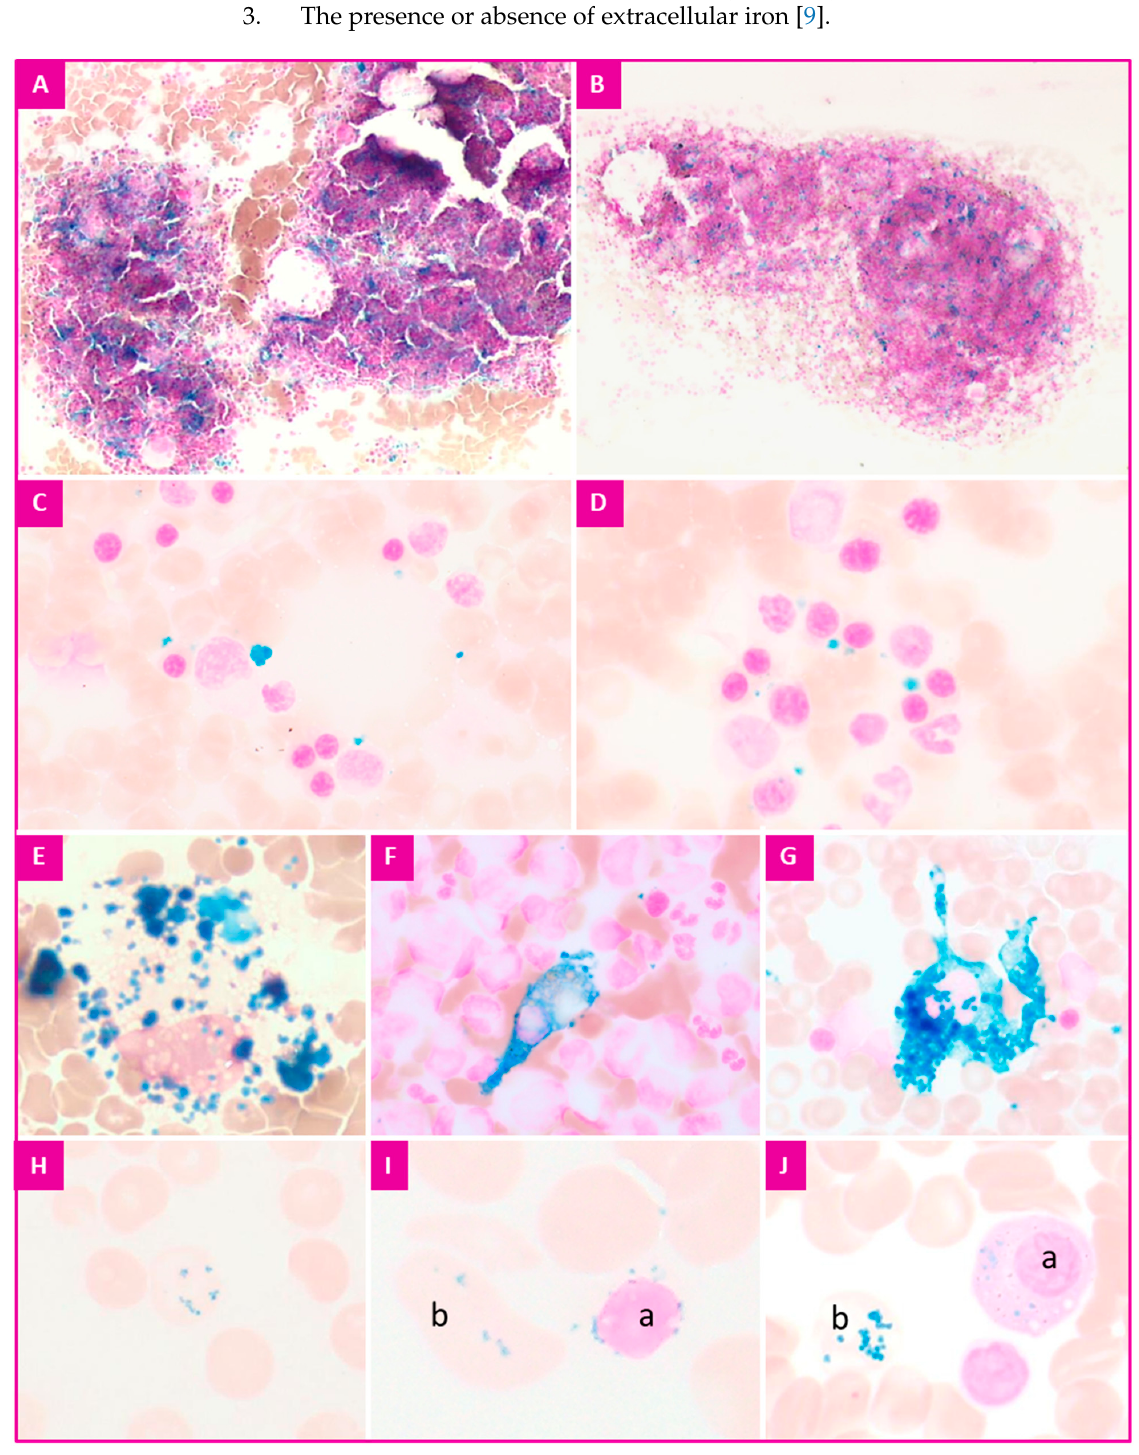
Figure 2. Prussian blue reaction of erythroid precursors, hematoxylin counterstain. ( A , B ) medullar iron content evaluation; ( C , D ) extracellular iron deposits; ( E – G ) macrophages; ( H ) siderocyte; ( I ) sideroblast (a) and siderocyte (b); and ( J ) hemosiderin-containing plasma cell (a) and one siderocyte (b). However, the evaluation of medullary iron stores through BM biopsy observed by anatomopathologists remains the reference